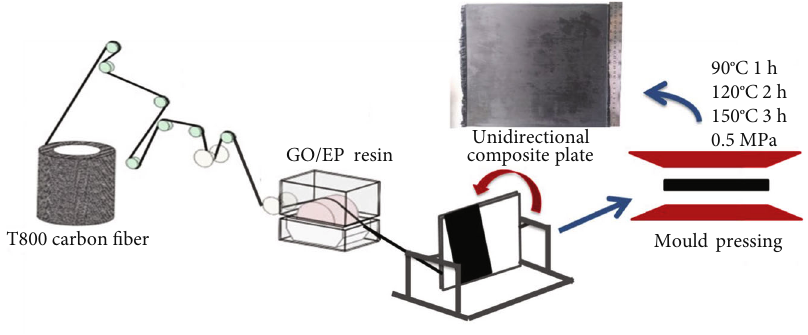
Figure 2: The schematic diagram of the preparation process for the GO-modi fi ed CFRP composites.